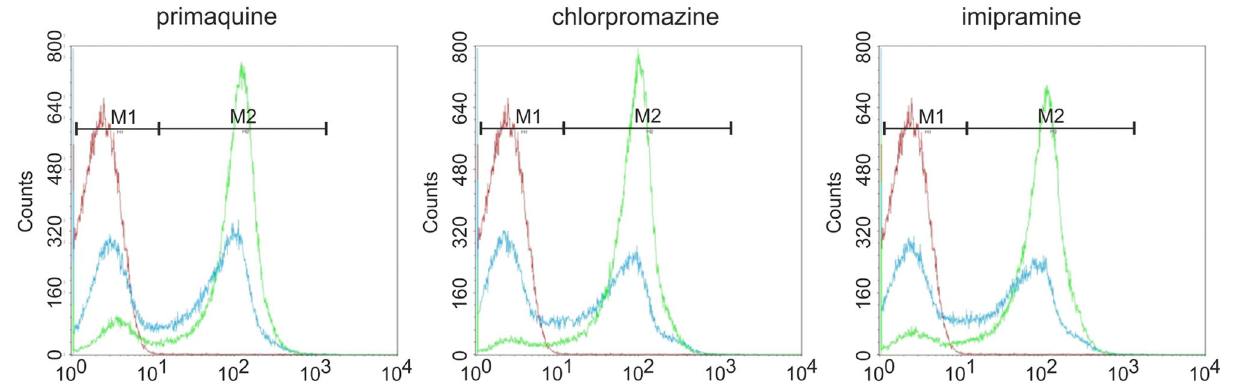
Figure 2. Dose-dependent uptake of fluid phase FITC-dextran by erythrocytes treated with amphiphilic drugs. Erythrocytes were suspended in FITC-labeled dextran and incubated with the indicated amphiphilic drugs to induce endovesiculation. Upon washing, the uptake of fluorescent label was quantified by flow cytometry. Representative histograms are shown. The concentrations were 1.5, 0.4 and 0.375 mM (blue) and 3.0, 0.6 and 0.75 mM (green) for primaquine, chlorpromazine and imipramine, respectively (red is a control incubation without drug). doi: